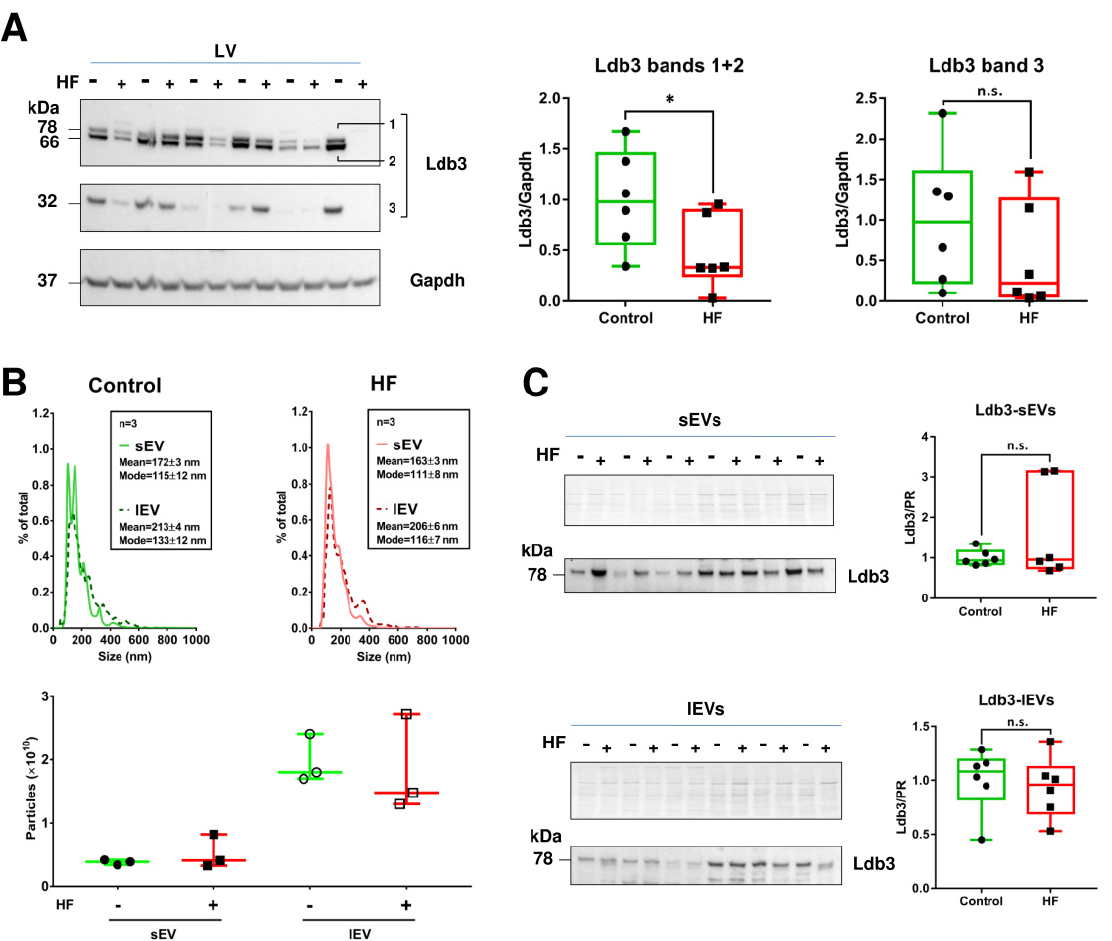
Figure 5. Ldb3 levels decrease in heart tissue, but not in cardiac EVs, during HF. ( A ) Western blots detecting Ldb3 expression in its 3 isoforms in left-ventricular tissue from control and HF patients. ( B ) NTA measuring particle size distribution (top panel) and concentration (bottom panel) of cardiac EVs isolated from the same patient tissues by UC. ( C ) Ldb3 detection in small (sEVs, top panel) and large EVs (lEVs, bottom panel). Data are expressed as median with interquartile range. * p < 0.05. Next, we verified if Ldb3 levels change in cardiac EVs during HF. Cardiac tissue from 6 control and 6 ischemic HF patients were minced and digested with collagenase II,